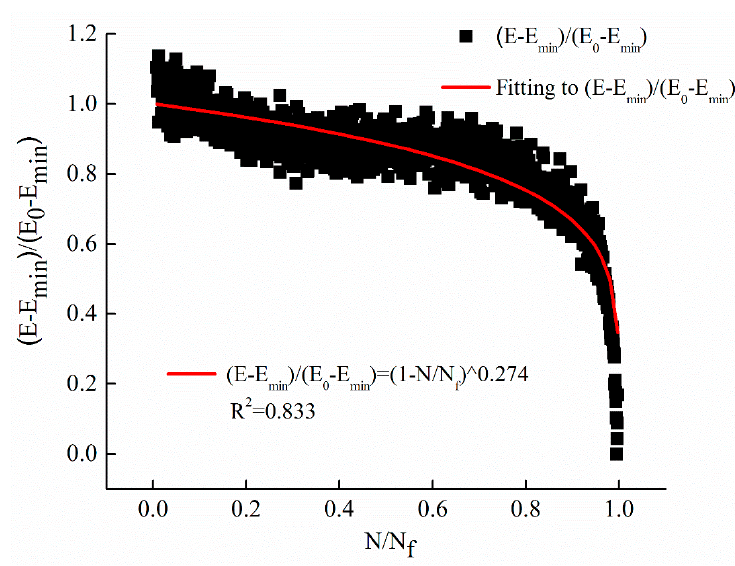
Figure 7. The regression results with stress levels of 0.5 MPa.